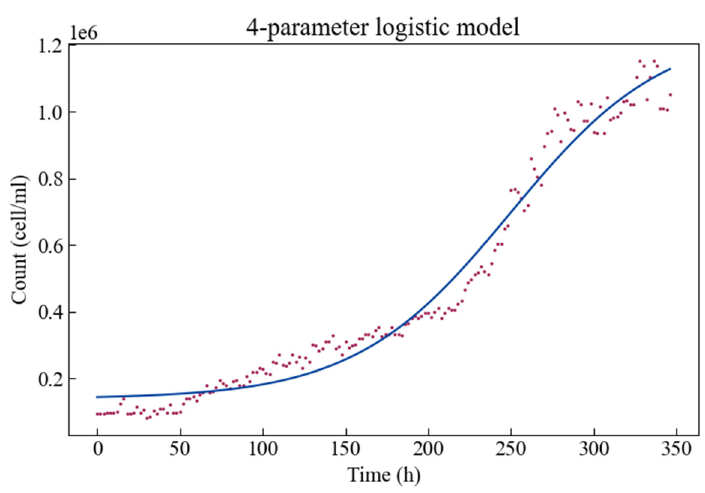
Figure 2. The four-parameter logistic growth model fitted to the Scenedesmus obliquus growth curve.